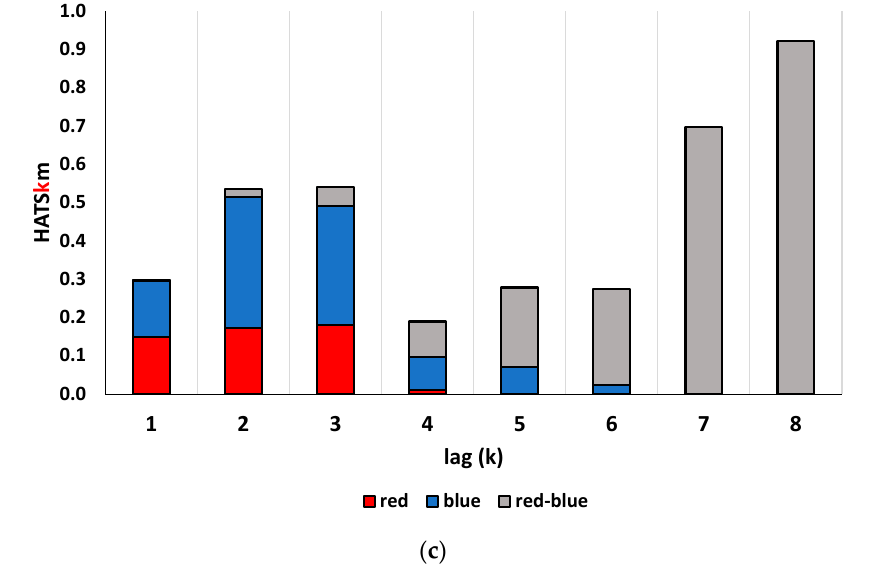
Figure 6. ( a ) Substructure 4 with numbered atoms; ( b ) Impact of lag value (k) on atomic pairs with the largest contribution to the descriptor’s value for substructure 4; ( c ) Contributions from atomic pairs within the R4 (blue) fragment and between the common core and R4 (red ‐ blue), which covered 100% of HATS(k)m value for different lag (k).